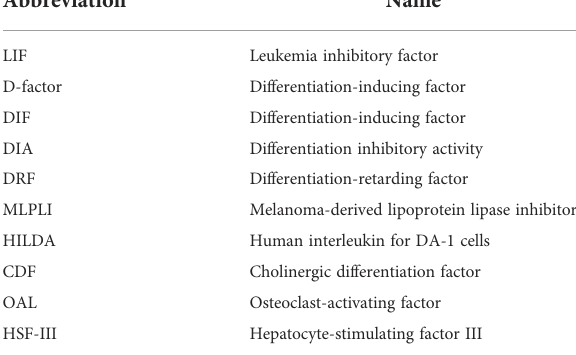
TABLE 1 Synonyms for LIF.